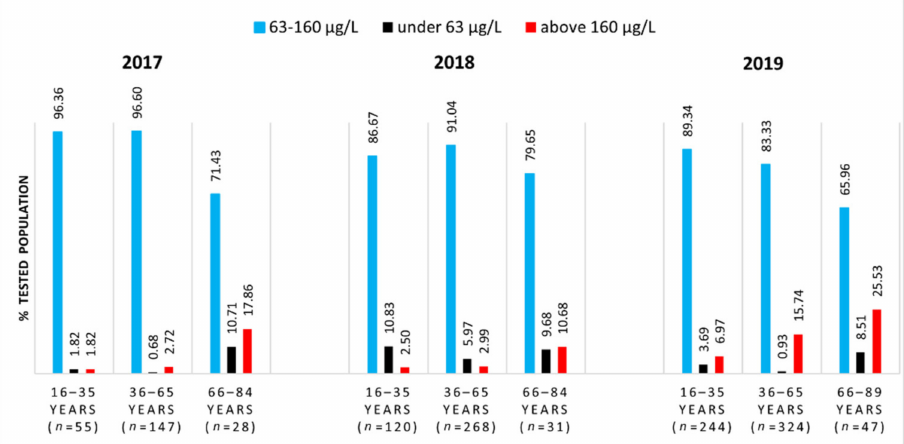
Figure 1. Distribution of tested population according to the SeS reference range of 63–160 µ g/L.